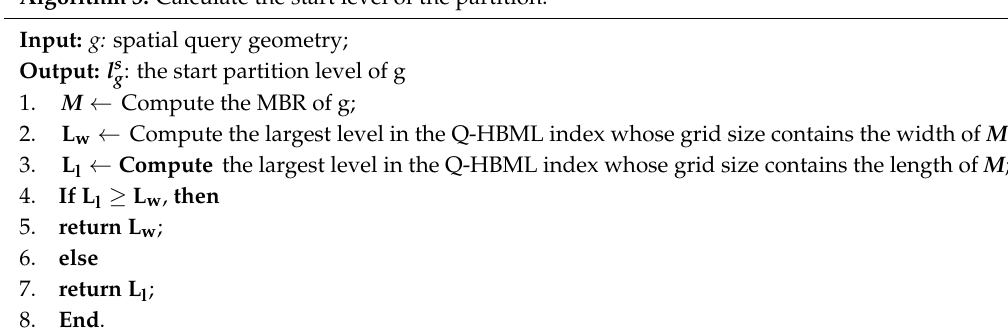
Algorithm 3. Calculate the start level of the